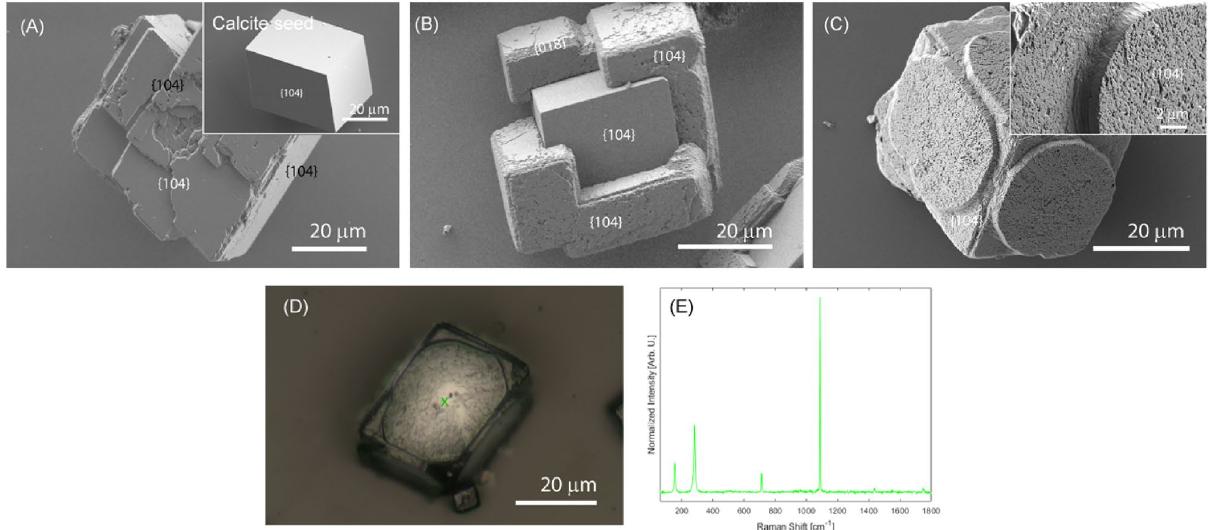
Figure 5. SEM images of CaCO 3 products obtained from overgrowth experiments. ( A ) Control experiment, i.e., overgrowth experiment in the absence of soluble fraction of the skeletal OM. ( B ) Overgrowth experiment in the presence of 13.3 µg/mL of SOM extracted from O. patagonica . ( C ) overgrowth experiment in the presence of 33.3 µg/mL SOM extracted from S. pistillata . The insets show details of the overgrowth of CaCO 3 . The Miller index of the crystalline faces is reported. ( D ) Optical microscope image of an overgrown disc-like mineral on the surface of a calcite seed. ( E ) Raman spectrum collected at the point indicated by the green cross in ( D ), the vibrational absorption bands observed indicate only the presence of